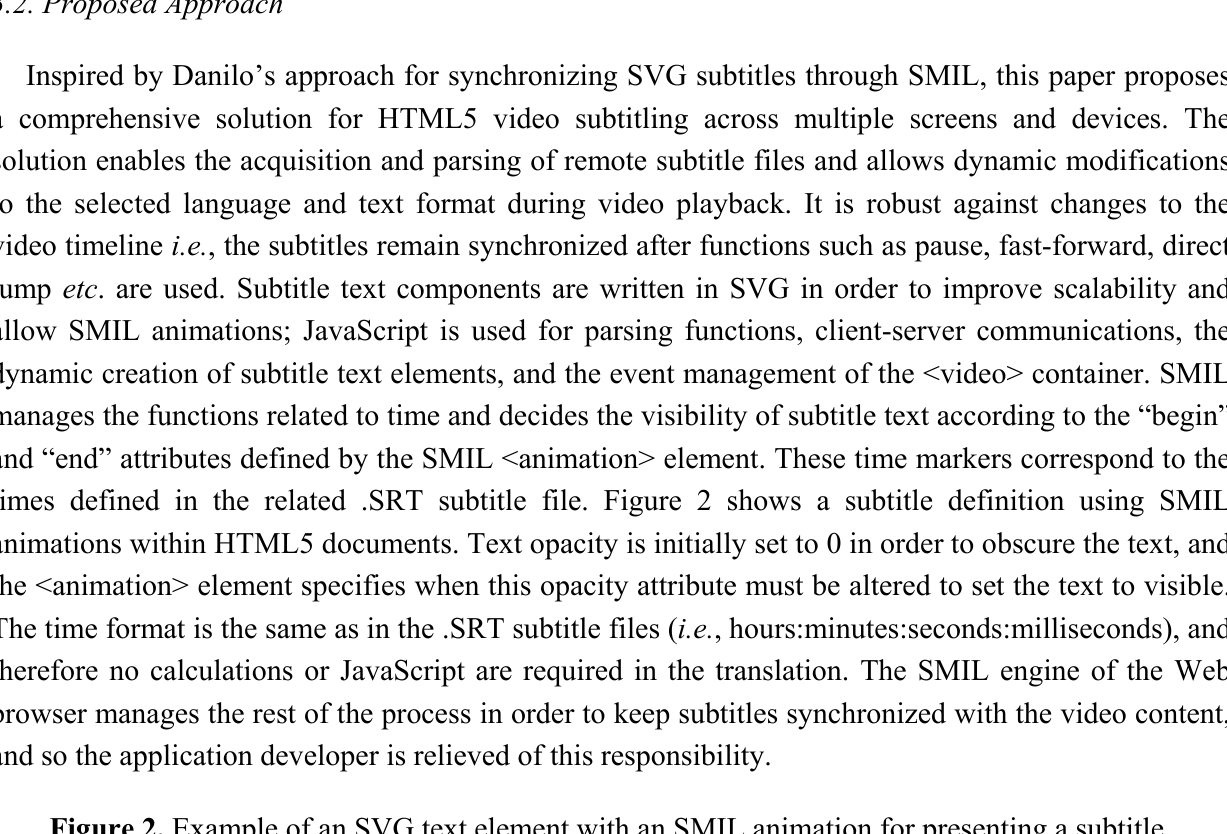
Figure 2. Example of an SVG text element with an SMIL animation for presenting a